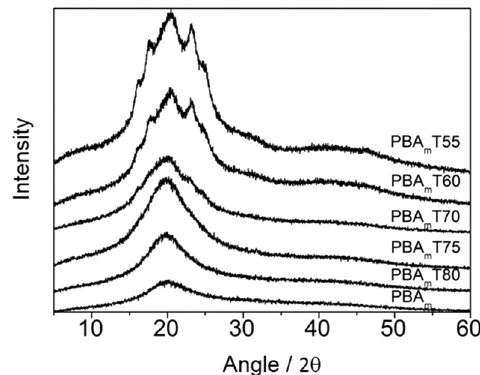
Figure 3: XRD patterns of PBA m T copolyesters and PBA m